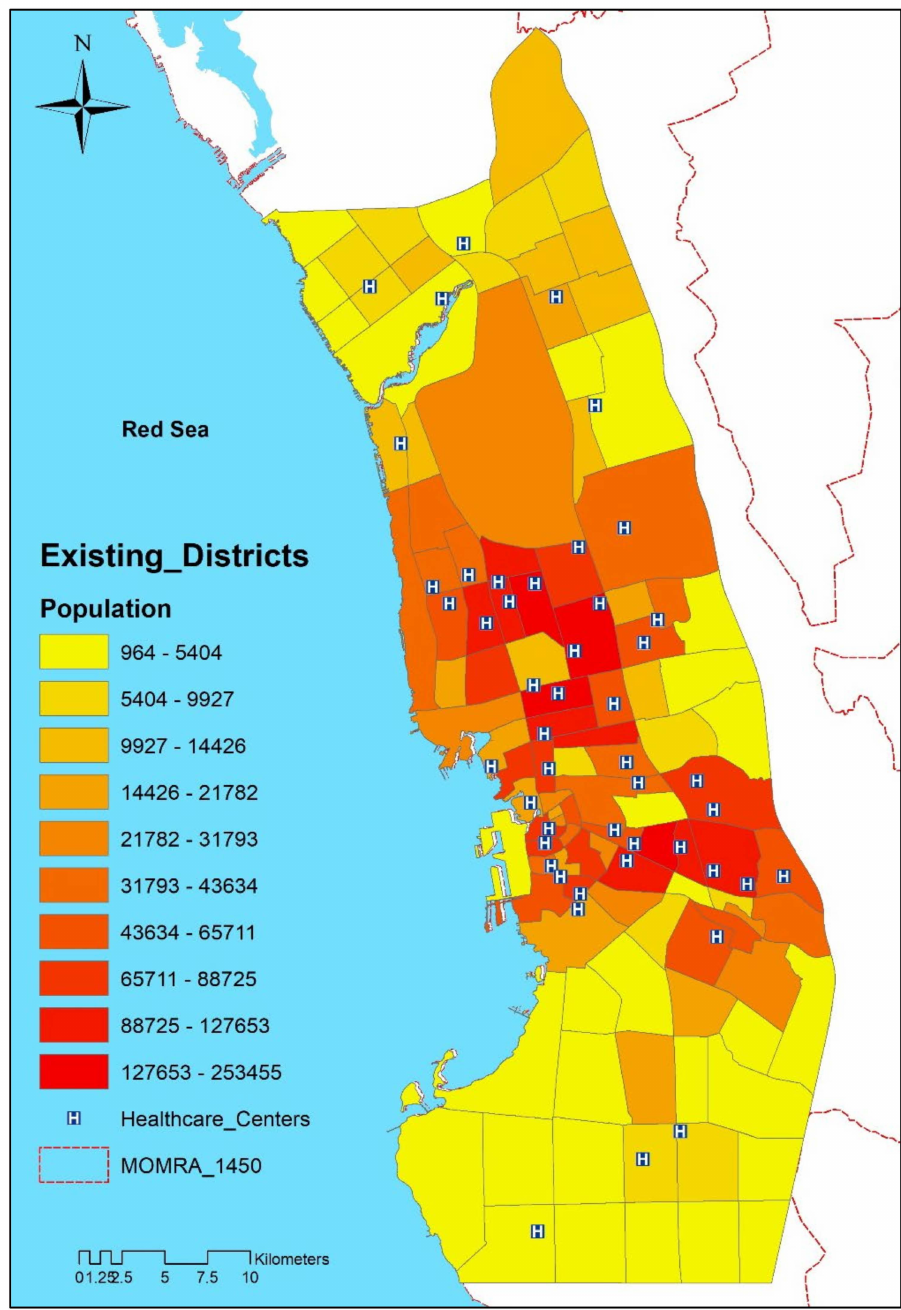
Figure 1. Spatial distribution of population districts and healthcare centers. Note: districts classified by population using the Natural Breaks (Jenks) within the ArcGIS